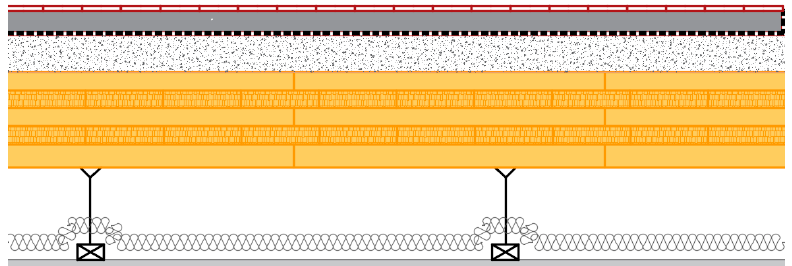
Figure 6. Configuration 4: Bare floor coupled with floating floor and suspended ceiling.